Question: What style of plot is this figure drawn as?
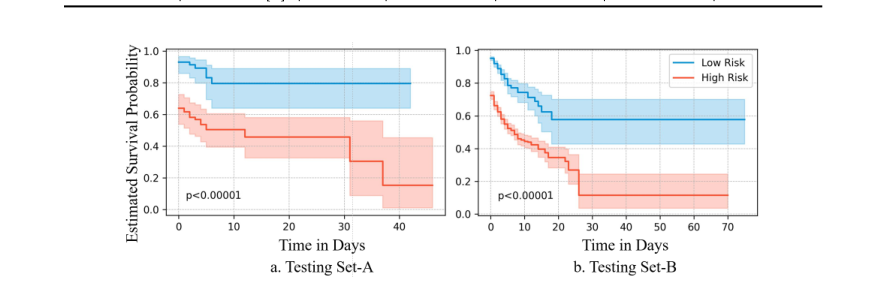
Answer: survival